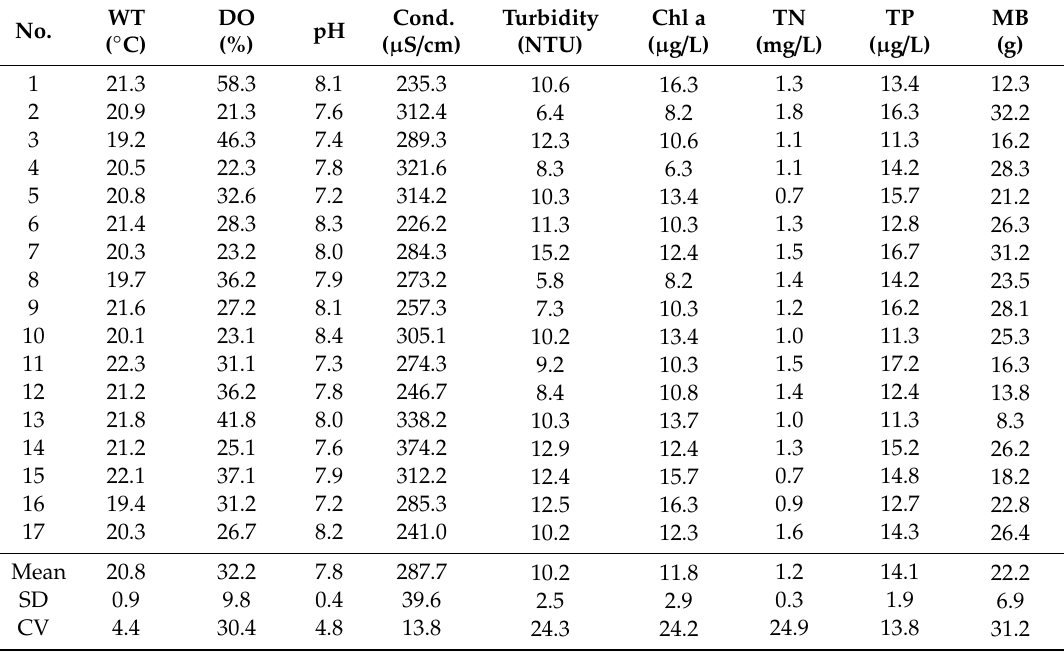
Table2. Environmentalvariablesin17riverinewetlands. WT,watertemperature; DO,dissolvedoxygen; Cond., conductivity; Chl a, chlorophyll a; TN, total nitrogen; TP, total phosphorus; MB, macrophyte biomass; SD, standard deviation; CV, coe ffi cient of variation